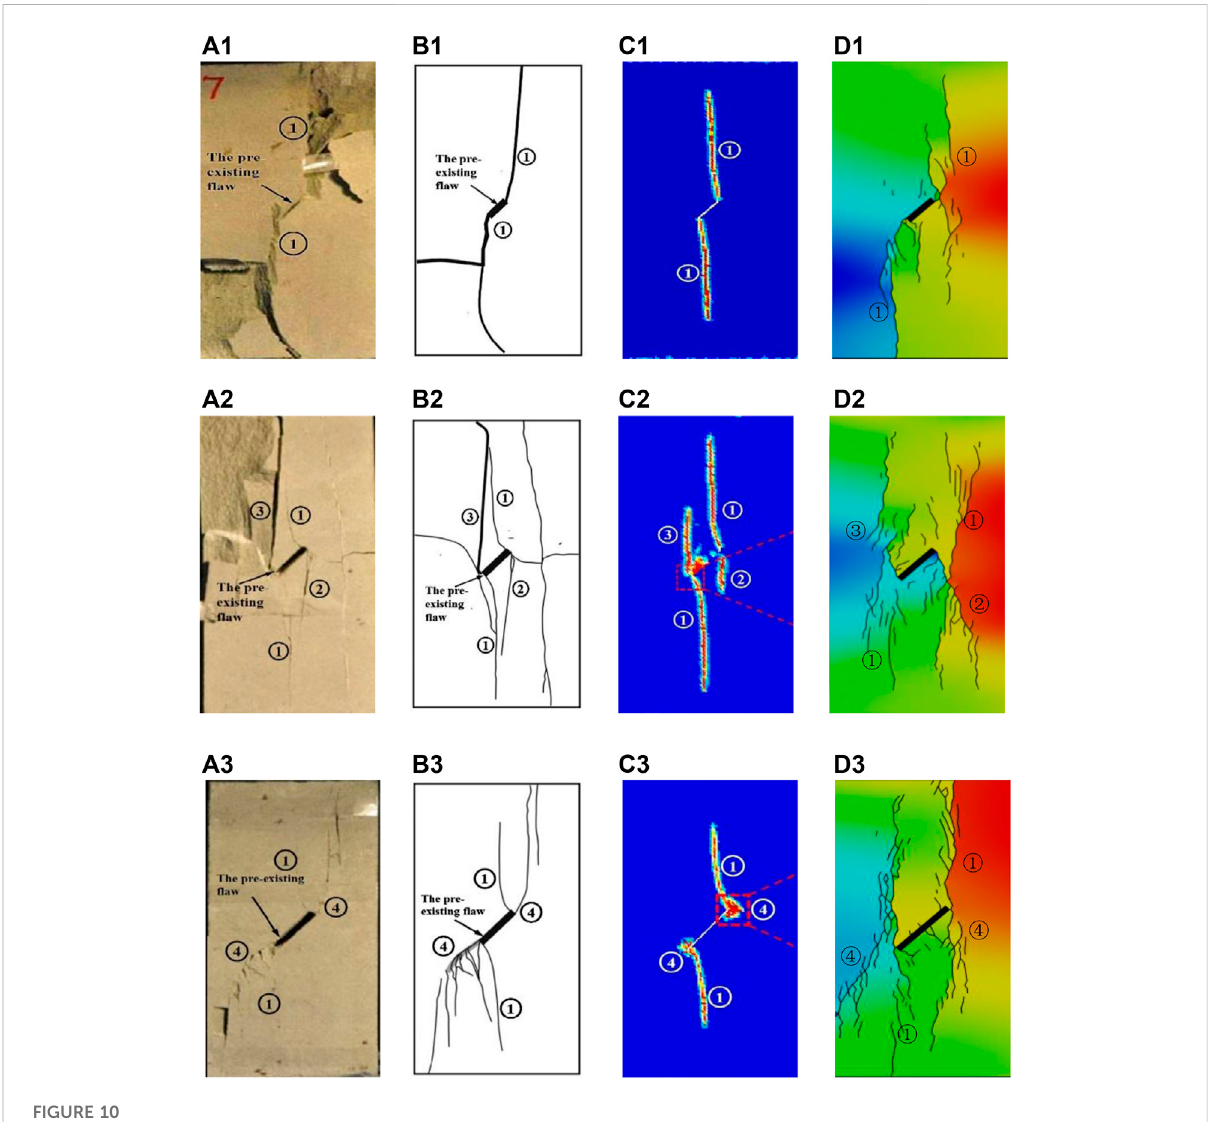
FIGURE 10 Comparison of numerical simulation